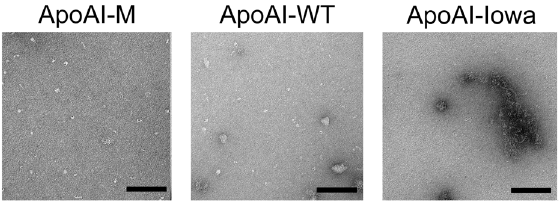
Figure 5. Electron microscopy (negative stain) analysis shows no fibril formation of apoA-I-M after four weeks of incubation at 37 6 C. ApoAI-Milano (R173C), apoAI-WT and apoAI-Iowa (G26R) proteins were incubated at 37 u C for four weeks followed by negative stain EM analysis. While the positive control apoAI-Iowa formed elongated fibrils (right panel), neither apoAI-WT (middle panel) nor apoAI-M (left panel) displayed any fibril formation. Size bars are 100